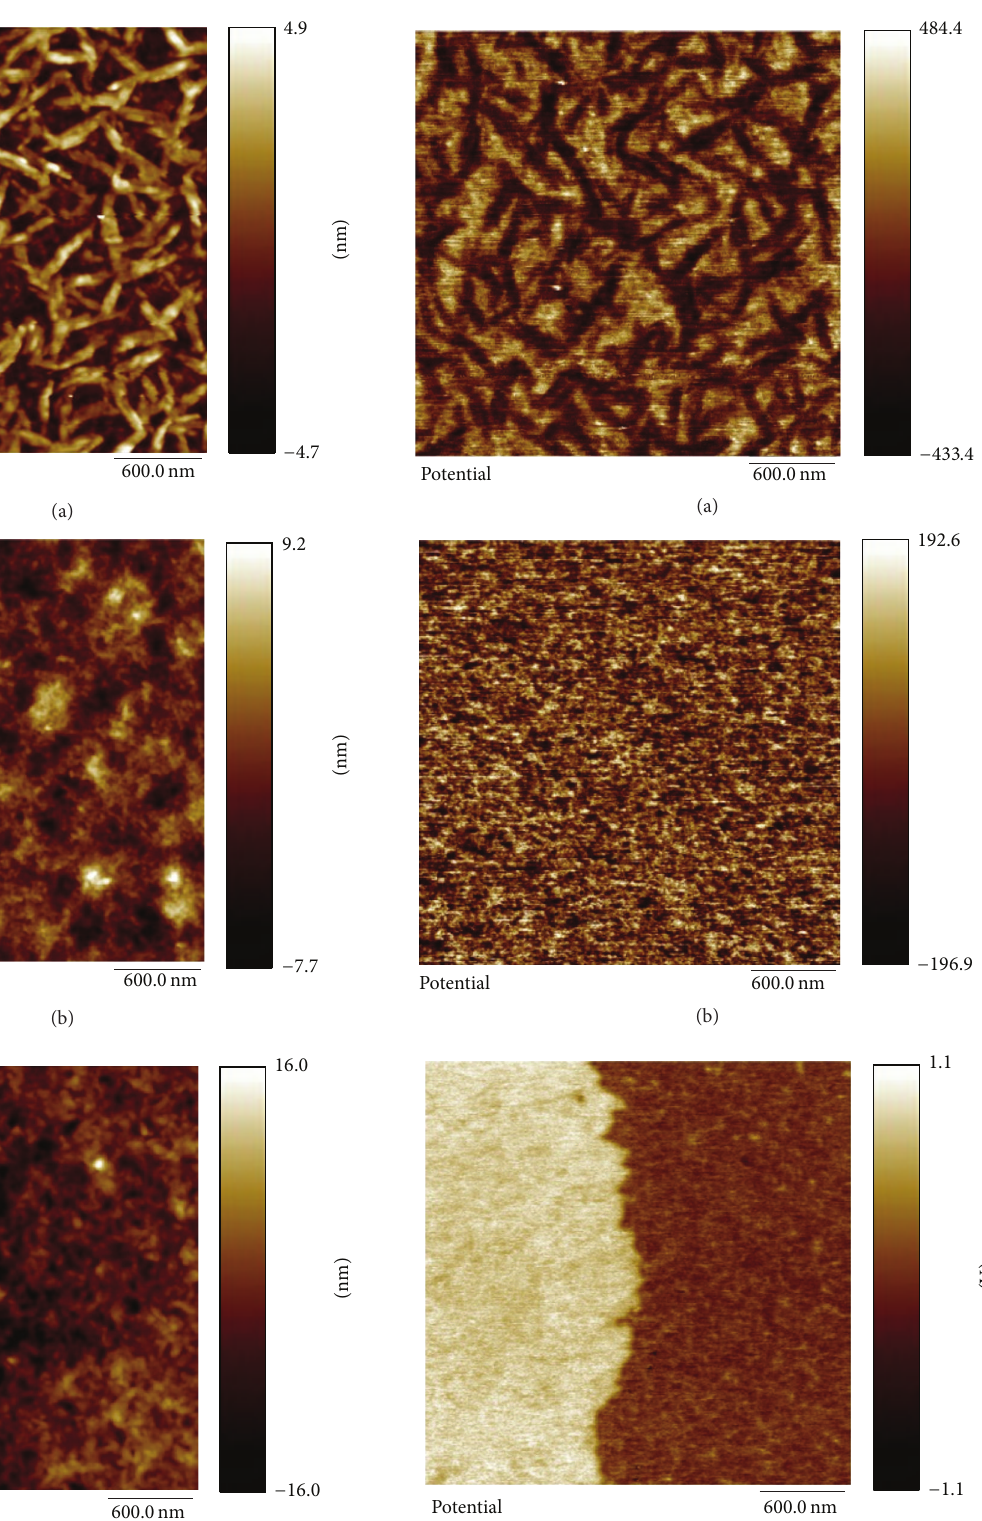
Figure 6: AFM Kelvin probe images of the as-cast (a), best performing-SVT with THF for 4s (b), and degraded-SVT with THF for 80 s